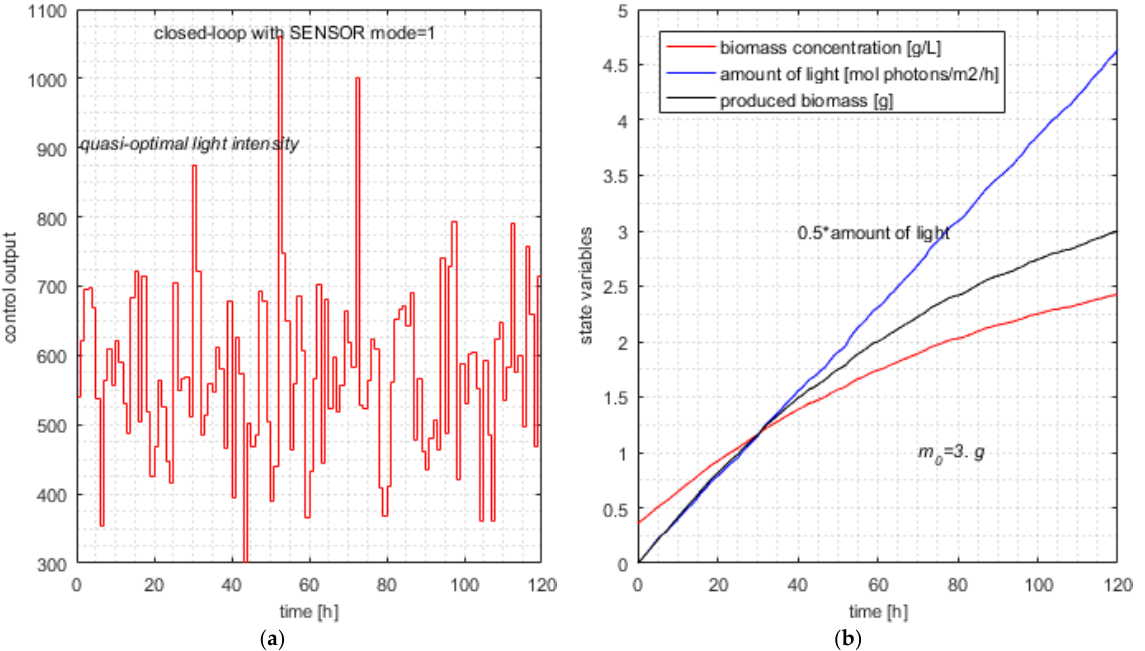
Figure 7. Typical simulation of the closed loop with SENSOR mode = 1. ( a ) Typical control output—controller with metaheuristic-based predictions; ( b ) quasi-optimal evolution of state variables and produced biomass.